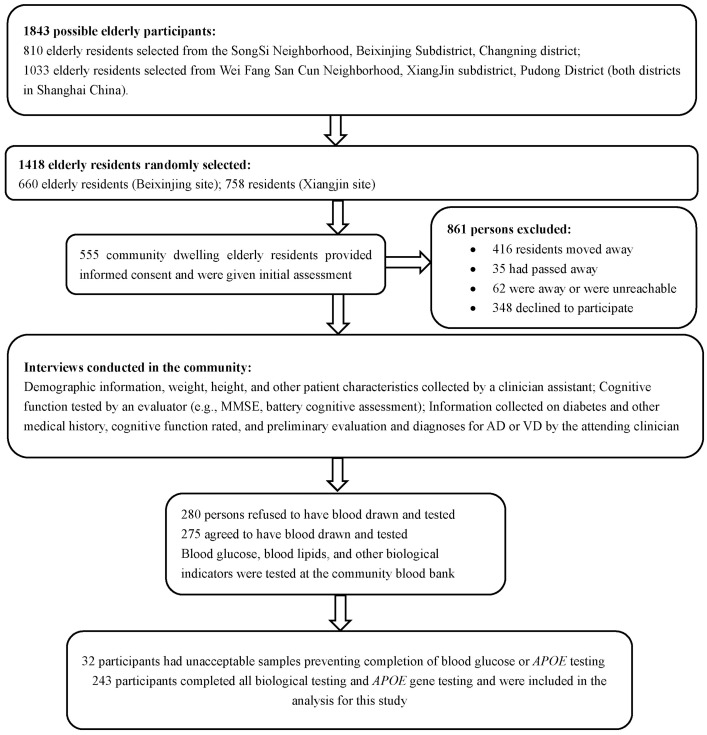
Flowchart of sample selection.MMSE = Mini Mental State Examination; AD = Alzheimer’s Disease; VD = Vascular Dementia; ApoE = Apolipoprotein E.